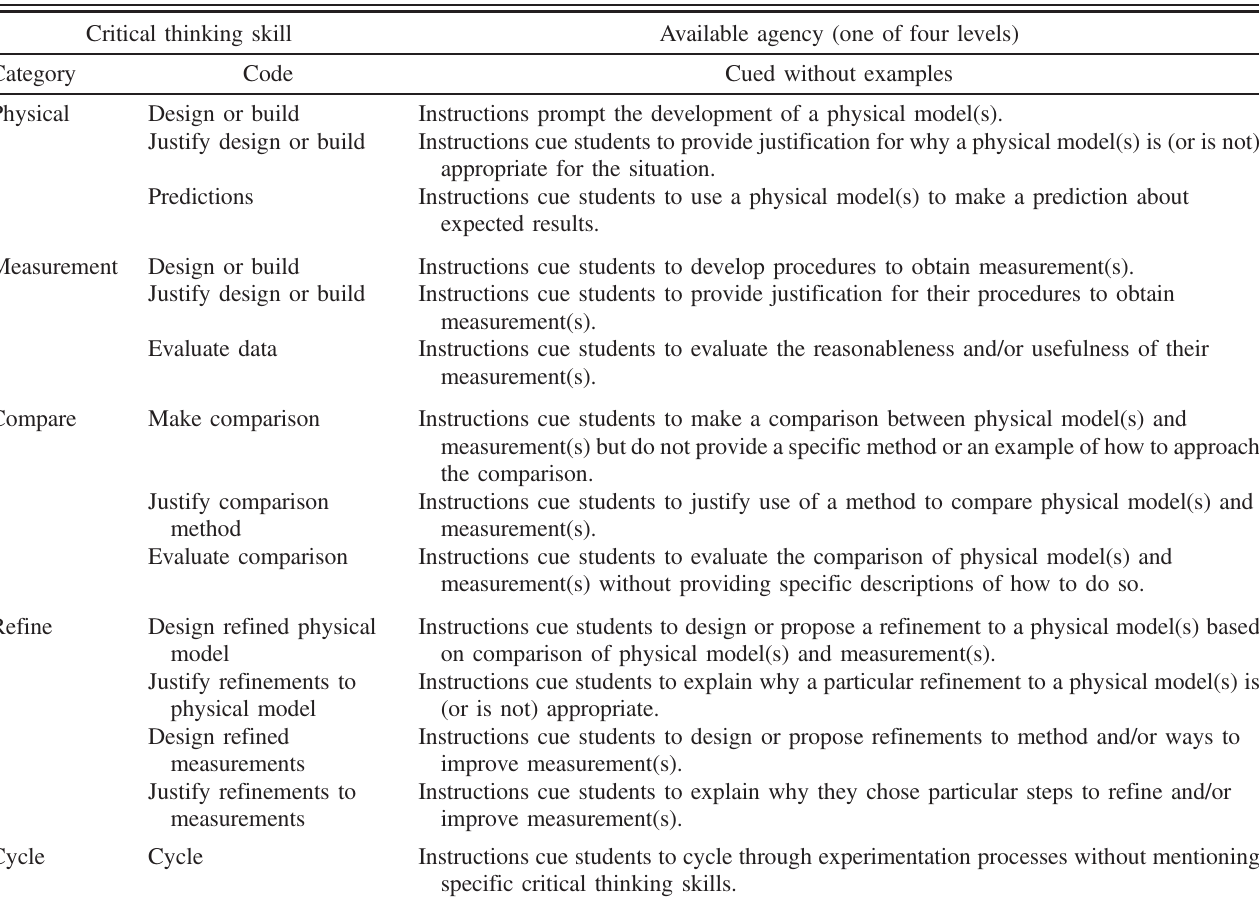
TABLE I. Descriptions of critical thinking skills codes with available agency. Only one level of available agency is listed for simplicity. “ Cued with examples ” is similar to “ cued without examples ” except that examples are provided in the instructions. “ Unprompted ” is a null code that refers to a complete lack of the code in the